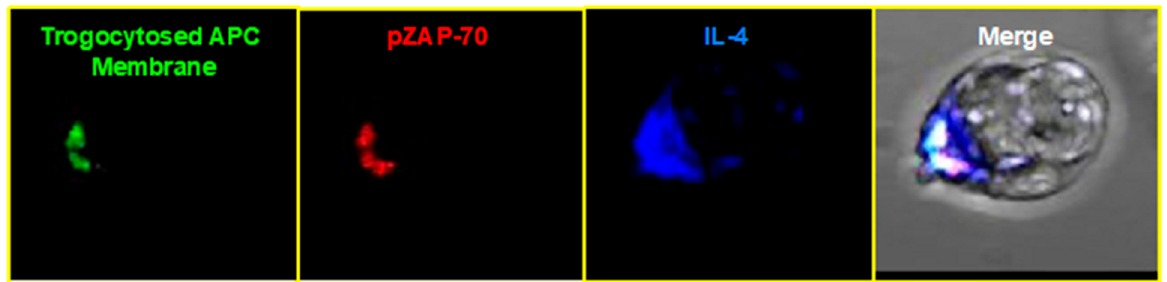
Figure 3. IL-4 is polarized toward trogocytosed MHC:peptide and active TCR signaling (phosphorylated ZAP-70). TCR transgenic cells were incubated for 90 min with APCs expressing GFP-tagged MHC:peptide. Cells were recovered, permeabilized, and stained for phosphorylated ZAP-70 and IL-4.